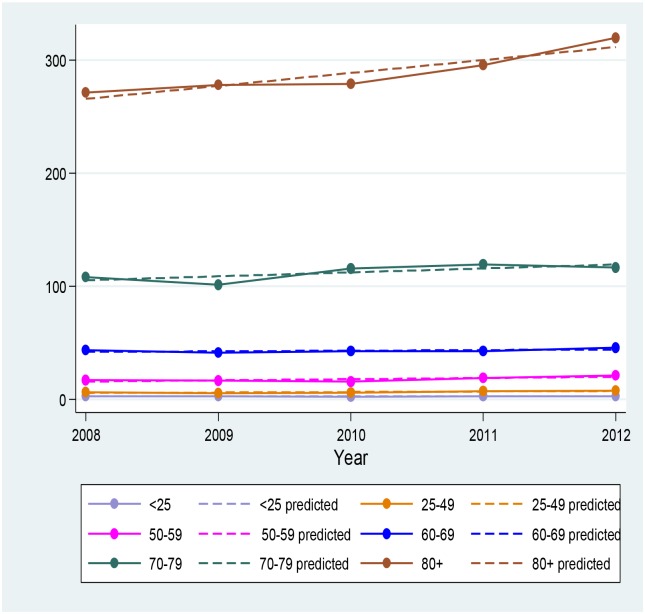
Trend in hospitalisation rates over time in the Australian population.